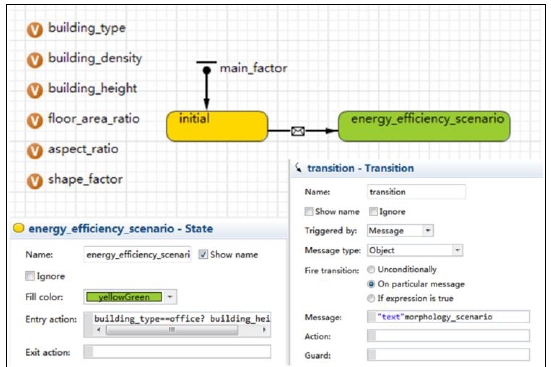
Figure 4. Urban morphology parameter update.